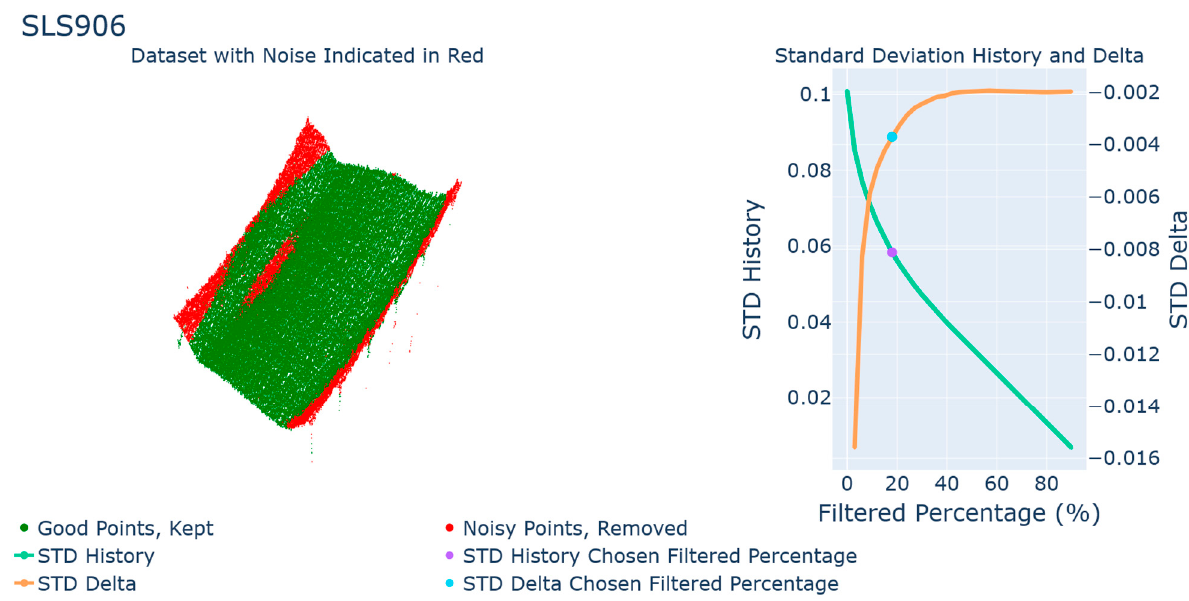
Figure 9. Results for the SLS part at 0° after 90° rotation.